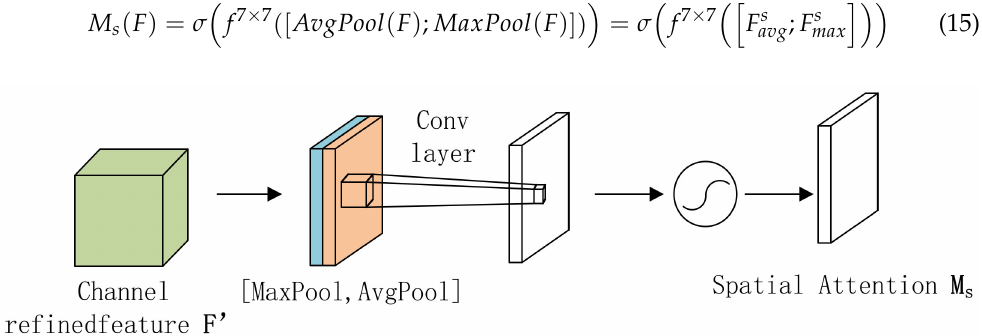
Figure 9. Spatial attention